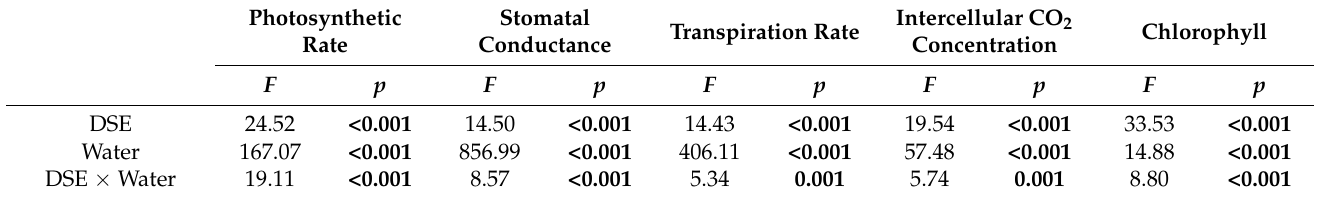
Table 3. The influences of DSE (DSE) and water (Water) treatments on the photosynthetic indexes and chlorophyll content of wheat leaves based on two-way analysis of variance (ANOVA).